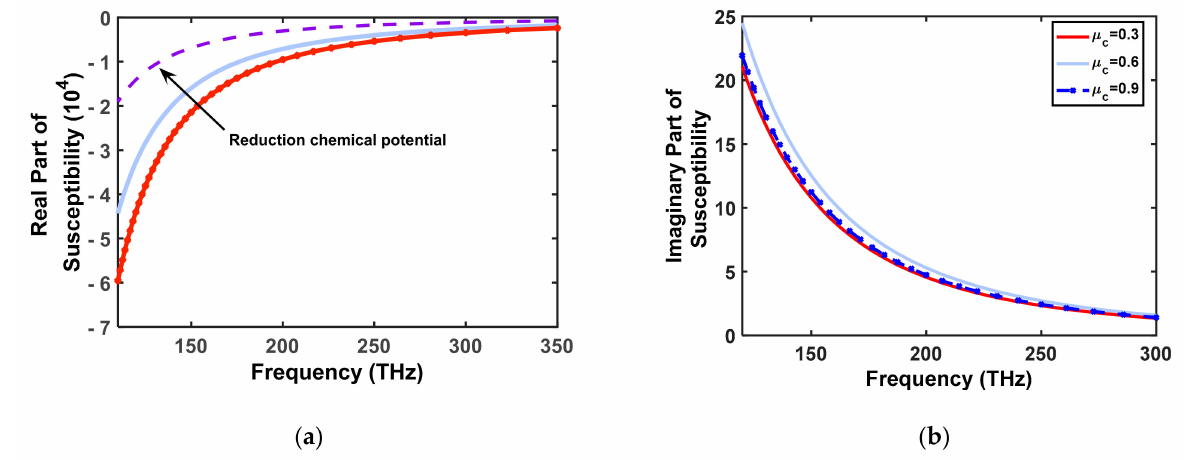
Figure 5. The real ( a ) and imaginary ( b ) parts of susceptibility versus frequency for different values of chemical potential.